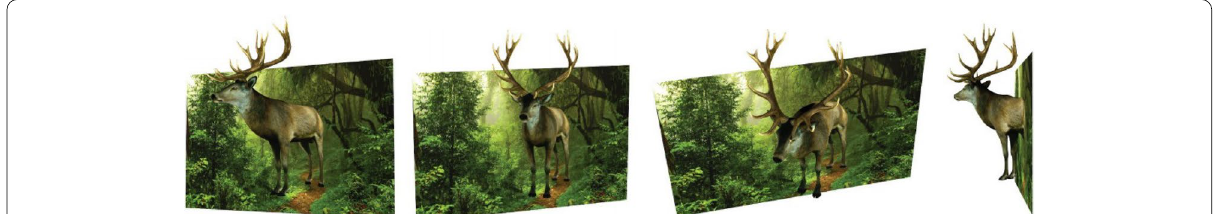
Fig. 28 The sculpture fabricated by Arpa et al.[72] is a mix of 2D images and 3D objects